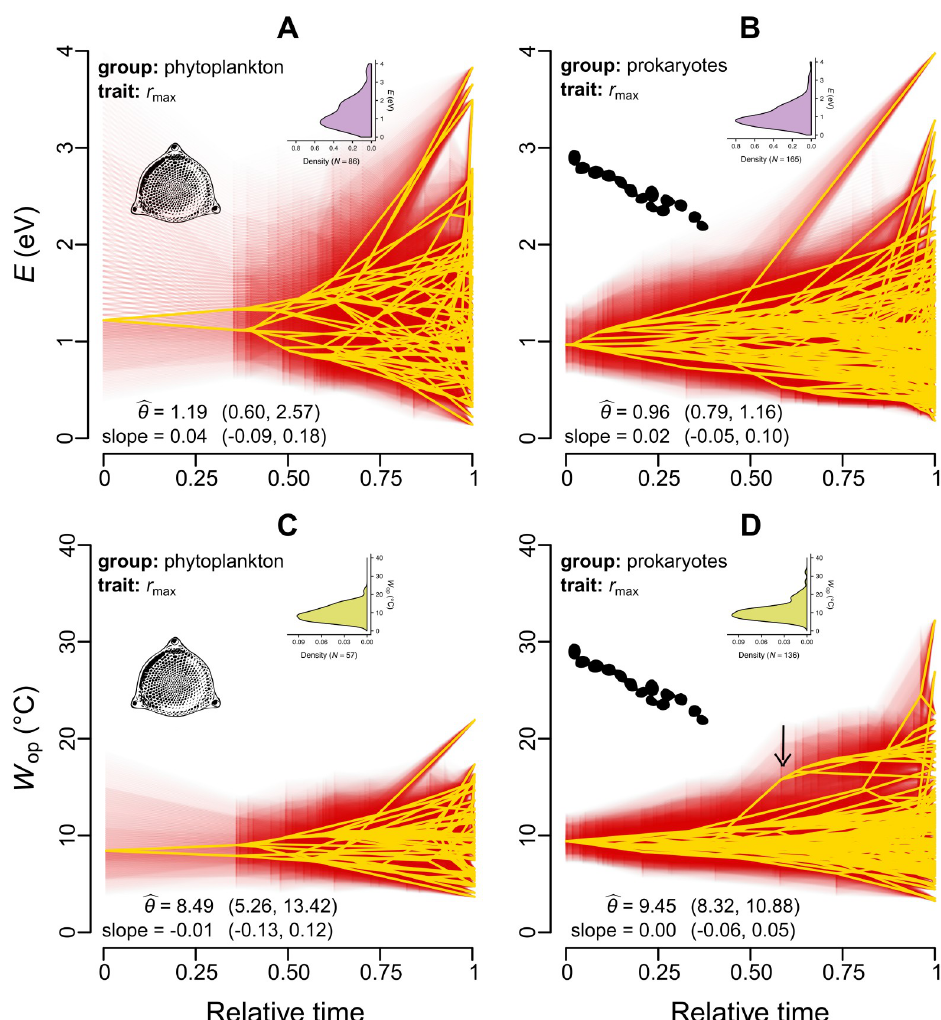
Fig 6. Projection of the phylogeny into thermal sensitivity versus time space. The values of ancestral nodes were estimated from fits of the stable model. Yellow lines represent the median estimates, whereas the 95% credible intervals are shown in red. ^ y is the estimated central tendency for each panel, whereas the existence of a linear trend towards lower/higher values is captured by the reported slope. Parentheses stand for the 95% HPD intervals for ^ y and the slope. All estimates were obtained for ln( E ) and ln( W op ), but the parameters are shown here in linear scale. The inset figures show the density distributions of E and W op values of extant species in the dataset. The arrow in panel D shows an example of a whole clade shifting towards high W op values, without being attracted back to ^ y . The raw data underlying this figure are available at https://doi.org/10.6084/m9.figshare.12816140.v1. HPD, highest posterior density.